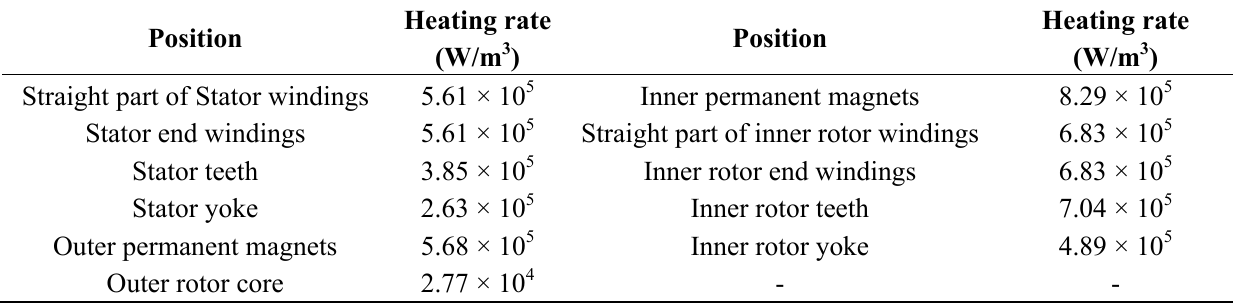
Table 4. Heating rates of different parts of the machine under rated